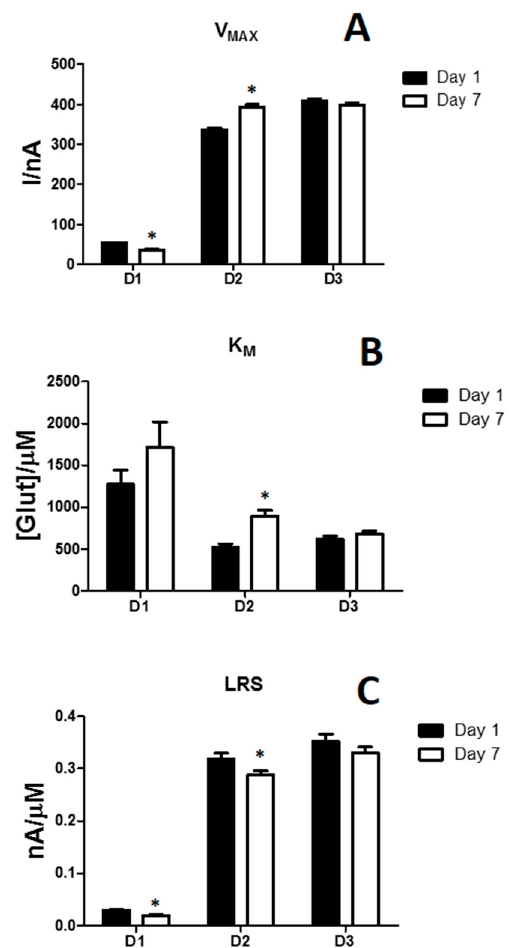
Figure 2. Bar chart describing the variation of V MAX (Panel A), K M (Panel B) and LRS (Panel C) on D1 , D2 and D3 biosensor designs at Day 1 (black bars) and Day 7 (withe bars). Values are expressed as mean ± SEM. * p < 0.05 vs. Day 1. D1 : Pt c /PPD/GluOx5/PG (0.1%); D2 : Ptc/PPD/PEI(1%) 2 /GluOx 5 /PG (0.1%); D3 : Pt c /PPD/PEI(1%) 2 /GluOx 5 /PEGDE (0.1%). Pt c : Pt cylinder 1 mm long, 125 µm diameter; GluOx: L-glutamate oxidase; PPD: poly-ortho-phenylenediamine; PEI: polyethyleneimine; PG: propylene glycol; PEGDE: Poly(ethylene glycol) diglycidyl ether. The subscript number represents the number of dip − evaporation deposition steps and in brackets the concentration of the component. Table 1. In vitro characterization of three different biosensor designs at Day 1 and day 7 in terms of Michaelis–Menten kinetic parameters (V MAX and K M ) and analytical parameters (Linear Region Slope –LRS, and LOD) for each design. D1 : Pt c /PPD/GluOx5/PG (0.1%); D2 : Ptc/PPD/PEI(1%) 2 /GluOx 5 /PG (0.1%); D3 : Pt c /PPD/PEI(1%) 2 /GluOx 5 /PEGDE(0.1%). Pt c : Pt cylinder 1 mm long, 125 µm diameter; GluOx: L-glutamate oxidase; PPD: poly-ortho-phenylenediamine; PEI: polyethyleneimine; PG: propylene glycol; PEGDE: Poly(ethylene glycol) diglycidyl ether. The subscript number represents the number of dip − evaporation deposition steps and in brackets the concentration of the component.